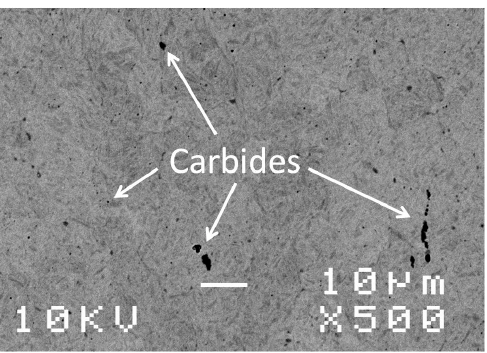
Figure 3. SEM image of the microstructure of the AISI A8 tool steel for Sample 1. Several secondary